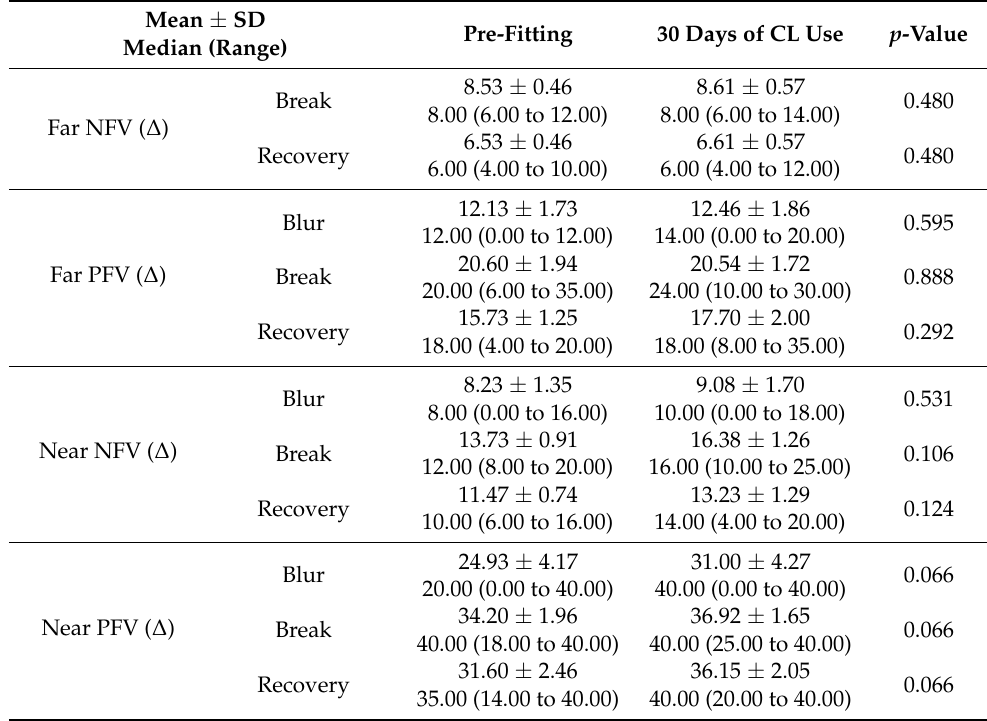
Table 3. Fusional vergence data at a distance and near obtained before the fitting and 30 days after contact lens wear. Abbreviations: SD, standard deviation; CL, contact lens; NFV, negative fusional vergence; PFV, positive fusional